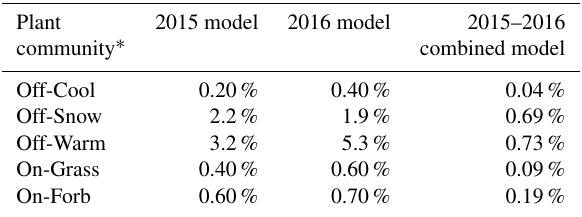
Table 3. Out-of-bag misclassification error rates (%) for each plant community for 2015, 2016, and combined-year random forest mod-